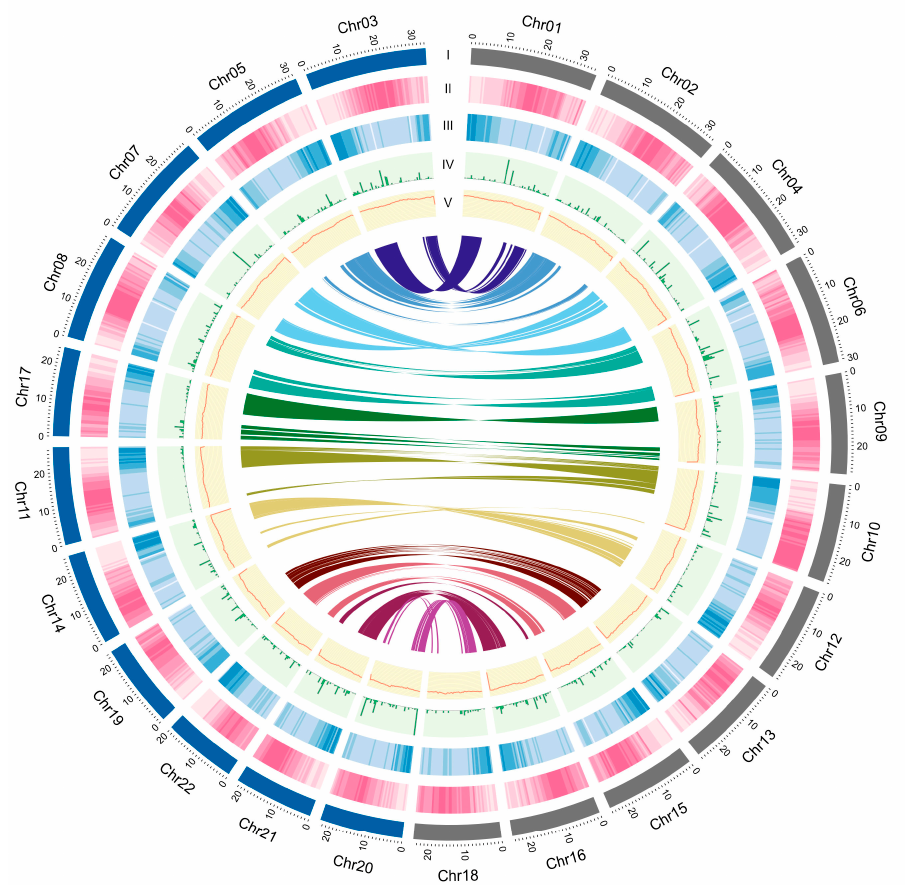
Figure 2. Genomic landscape of M. speciosa . (I) A physical map of 22 pseudomolecules (chromosomes) numbered according to size (in Mb); (II) Content of repetitive sequences shown as proportion of genomic regions covered by repetitive sequences in 250-kb windows; (III) Gene density represented by the number of genes in 250-kb windows; (IV) SNP density represented by number of SNP markers in 250-kb windows; (V) GC content represented by the percentage of G + C bases in 250-kb windows. Syntenic blocks in the genome are displayed by colored lines.